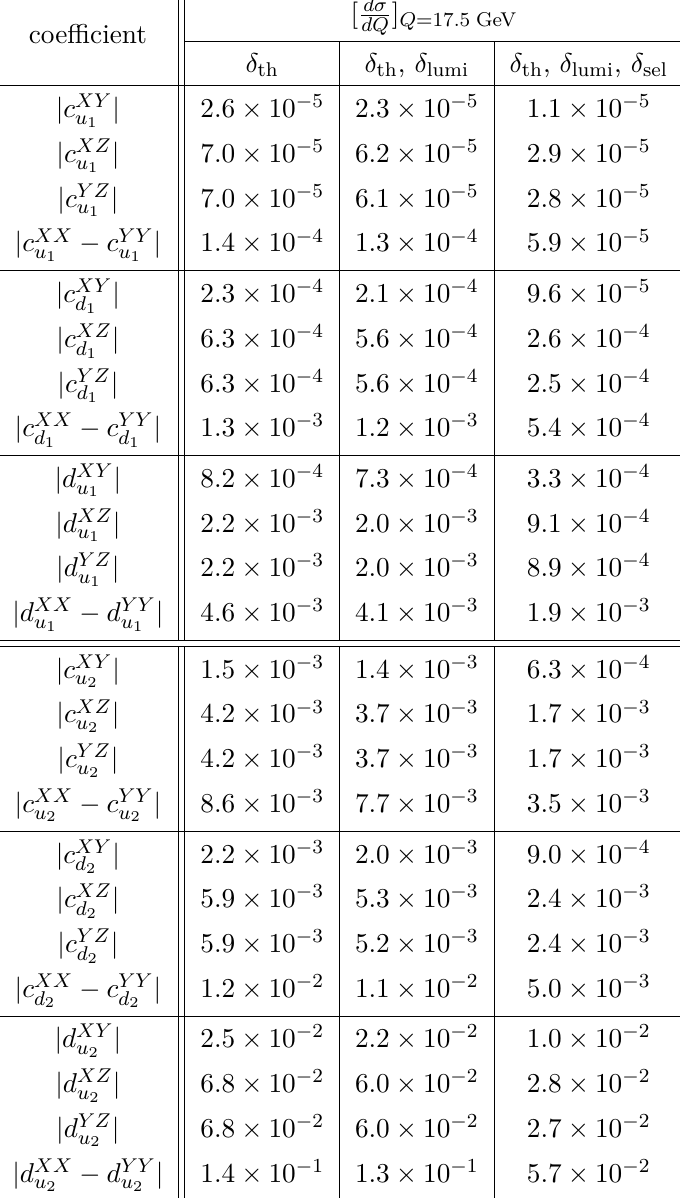
Table 3 . Expected best constraints of the time-dependent coefficients in the ( c u See the caption in table 2 for further